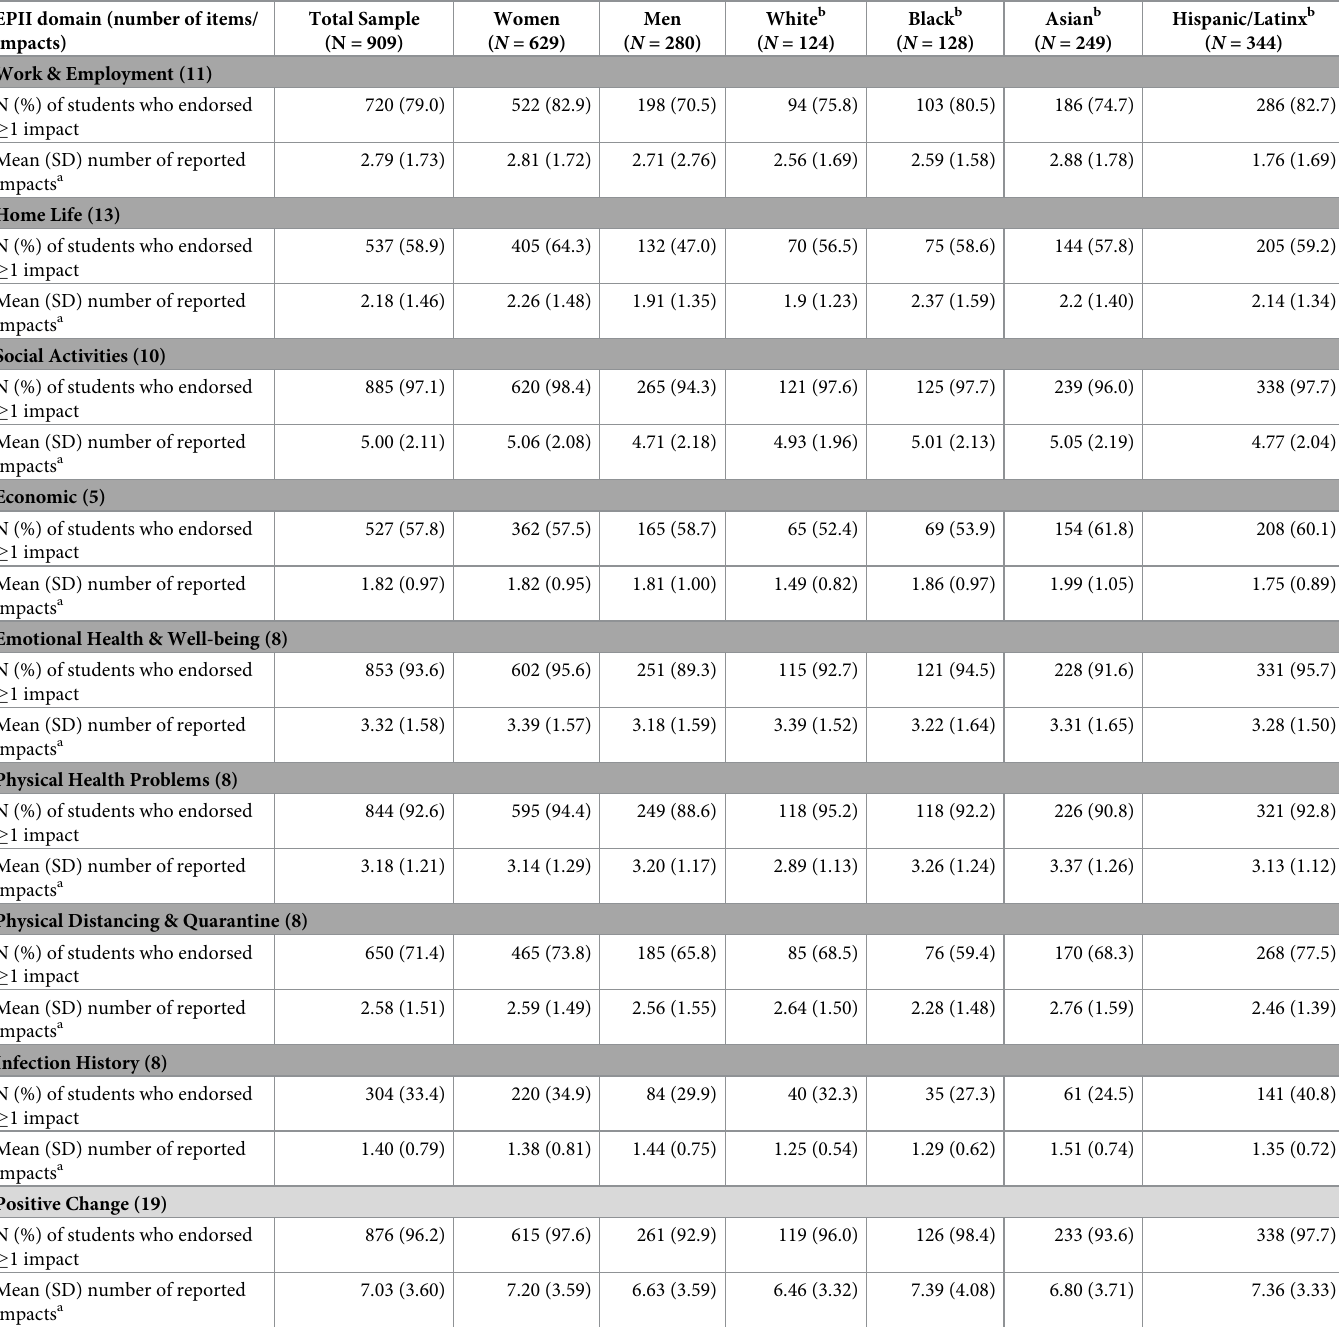
Table 2. COVID-19 impacts reported by the surveyed student sample (N = 909), and by sex and racial/ethnic group. EPII domain (number of items/